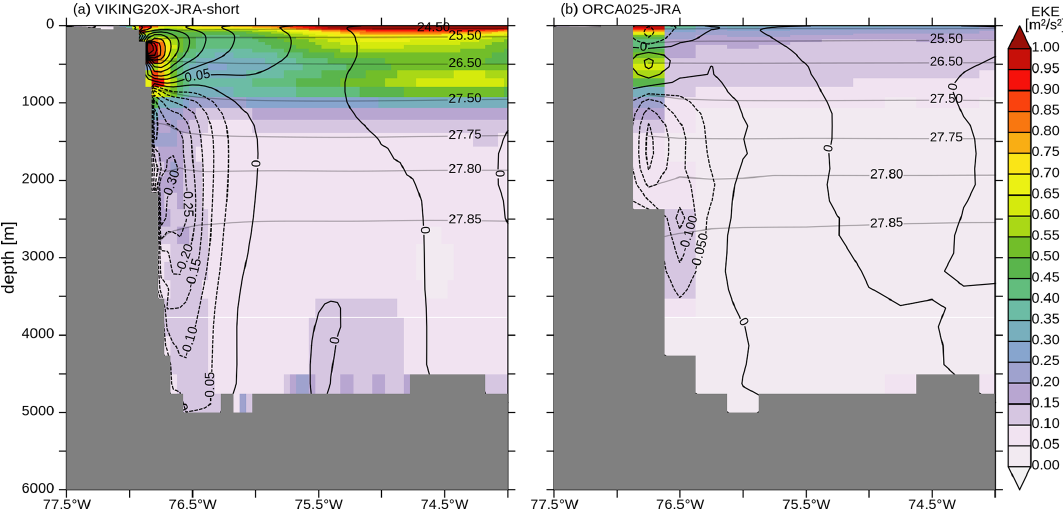
Figure 13. Mean (1990–2009) eddy kinetic energy (EKE) in m 2 s − 2 (shaded) and meridional velocity in ms − 1 (black contours) section at 26.5 ◦ N for (a) VIKING20X-JRA-short and (b) ORCA025-JRA with σ 0 isolines (grey). The Antilles Current is depicted by positive, northward velocities above 1000m depth near the coast. Table 7. Mean and monthly standard deviation of NBUC and DWBC transports across 11 ◦ S from 12 observational sections, mooring measurements and experiments for the period 2000–2019 (for VIKING20X-CORE 2000–2009) and sampled from monthly data according to the ship-based observational coverage (Obs.). The transport calculation is modified from Hummels et al. (2015) by changing from γ n to almost equivalent σ 0 criteria. For observations, transports based on γ n criteria are given as reference. (NBUC transport is calculated by integration of positive velocities in three boxes: west of 35.4 ◦ W above σ 0 = 27 . 53, between 35.0 and 34.65 ◦ W above σ 0 = 26 . 73, between 35.4 and 35 ◦ W above the line connecting σ 0 = 27 . 53 at 34.5 ◦ and σ 0 = 26 . 73 at 34.65 ◦ W. DWBC transport is calculated by integration of negative velocities west of 34.65 ◦ W between σ 0 = 27 . 53 and the second crossing of σ 0 = 27 . 88. All σ 0 criteria are based on temporally varying fields. The latter condition cannot always be fulfilled; if this second crossing does not exist, the integration is down to the bottom. These boxes are outlined in Fig.